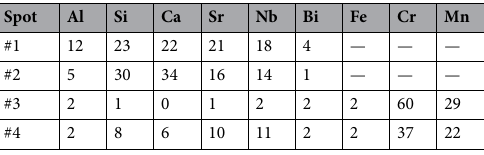
Table 1. Quantitative EDS results in Fig. 3 (in at.